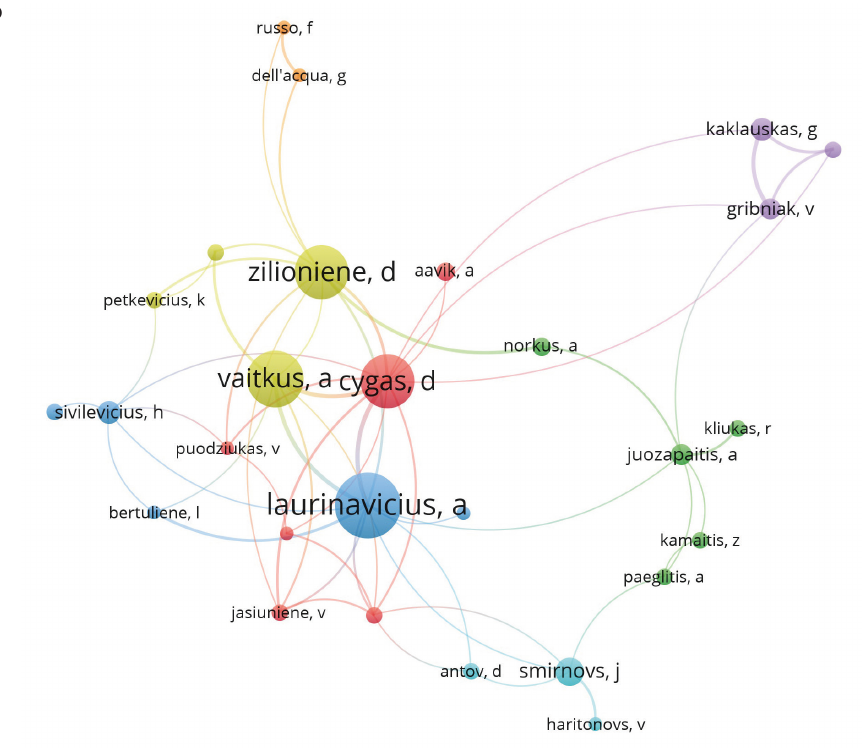
Figure 7. Author co-authorship network of the Baltic Journal of Road and Bridge Engineering publications